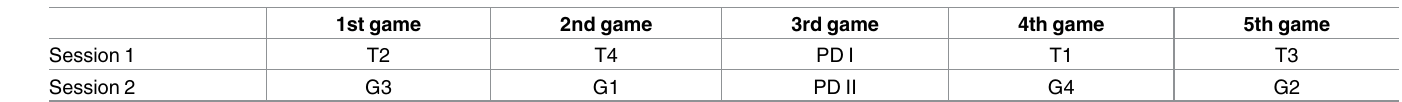
Table 3. Sequence of